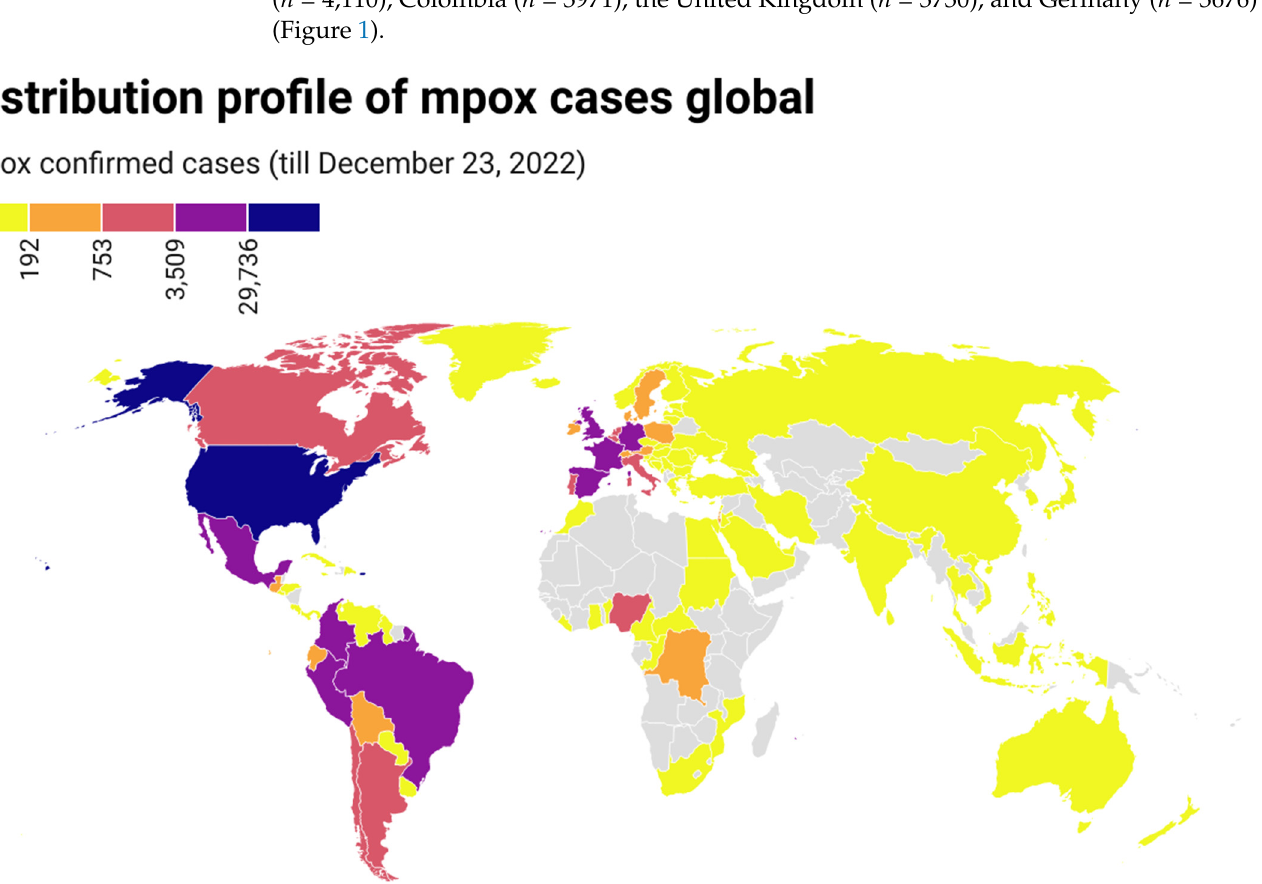
Figure 1. Geographic distribution of confirmed mpox cases from 7 May to December 23, 2022